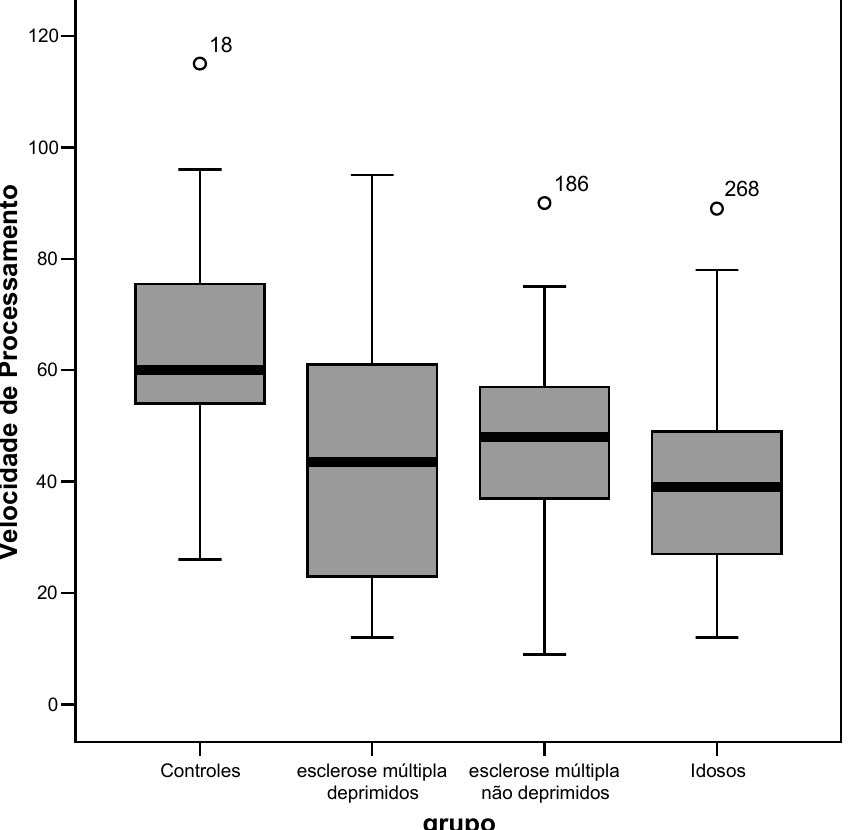
Figura 7 . Desempenho dos quatro grupos nos subtestes de velocidade de processamento da